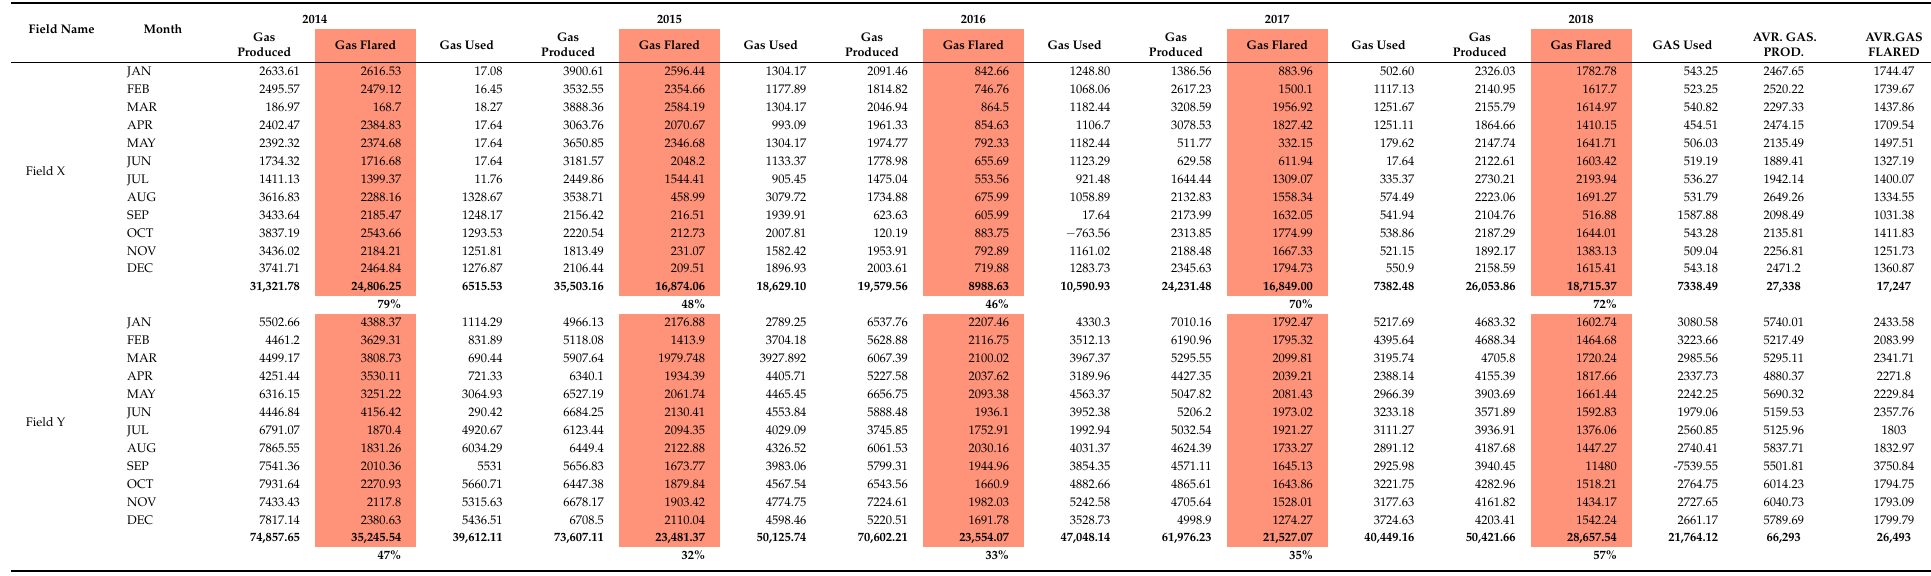
Table A1. Gas Production And Flare Volumes